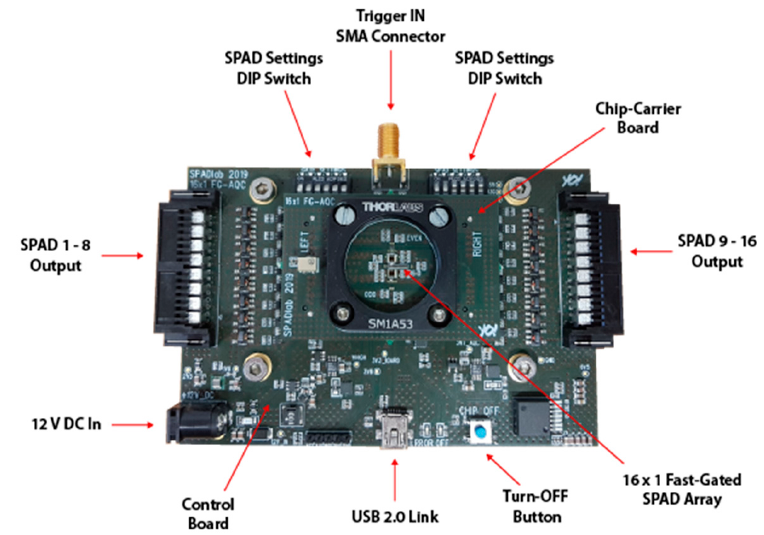
Figure 4. Picture of the complete 16 × 1 fast-gated SPAD array module. The chip carrier is equipped